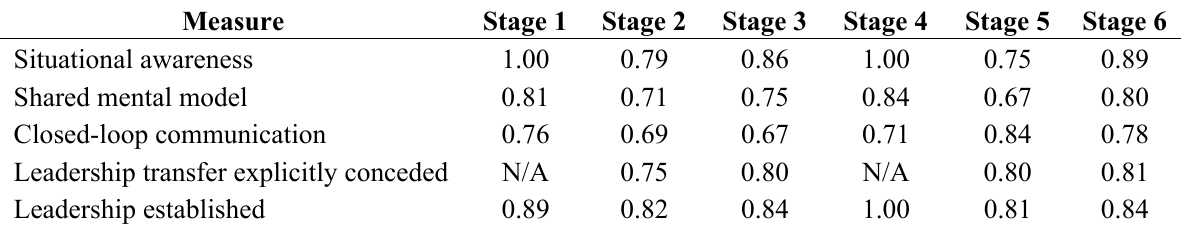
Table 5. Kappa ( κ ) scores for each measure of the observation instrument